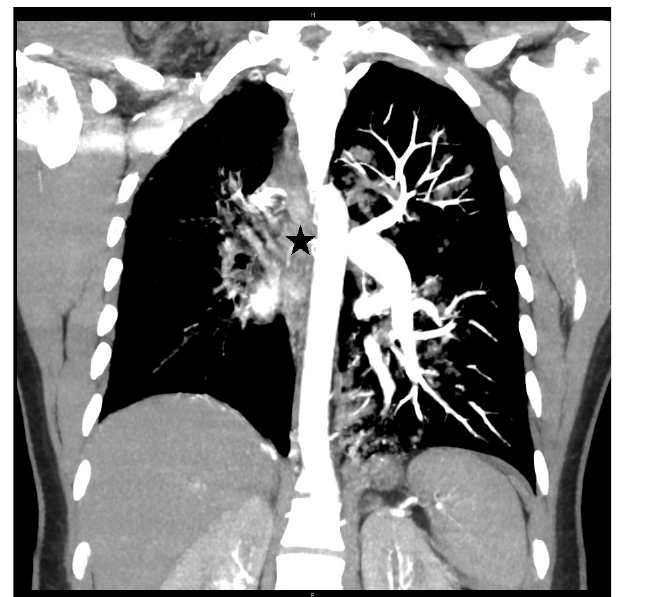
Image 2. A coronal view of a contrast-enhanced computed tomography angiography revealing an absent right pulmonary artery (star) and hypoplastic right lung.